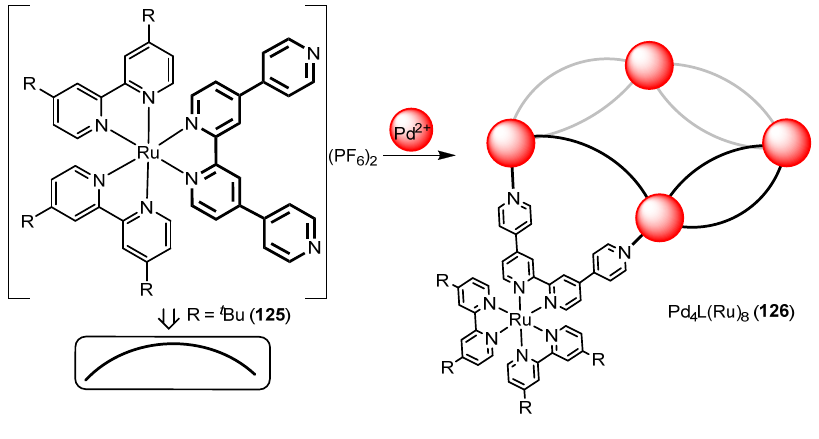
Figure 35. Schematic representation of the synthesis and structure of ring cage Pd 4 L 8 126 containing eight Ru-bipyridine derivatives 125 . Adapted from [113].